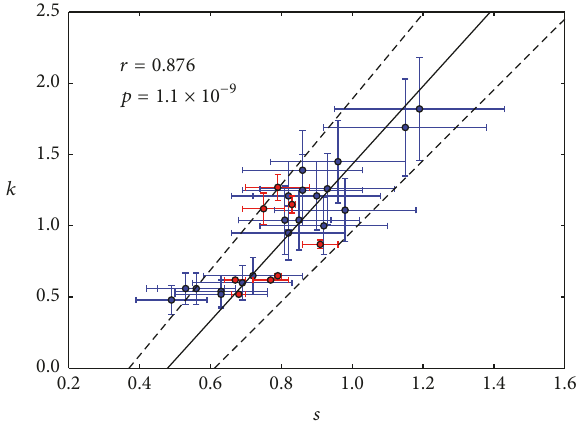
Figure 13: Luminosity ( 𝑘 )-stretch ( 𝑠 ) relation for relativistic type IcBL SNe [42]. For all filters from 𝑈𝐵𝑉𝑅𝐼 , and combinations thereof, GRB-SNe are shown in blue, and the two known relativistic type IcBL SNe (2009bb and 2012ap) are shown in red. A bootstrap analysis was performed to fit a straight line to the dataset to find the slope ( 𝑚 ) and 𝑦 -intercept ( 𝑏 ), which used Monte-Carlo sampling and 𝑁 = 10,000 simulations. The best-fitting values are 𝑚 = 2.72 ± 0.26 and 𝑏 = −1.29 ± 0.20 . The correlation coefficient is 𝑟 = 0.876 , and the two-point probability of a chance correlation is 𝑝 = 1.1 × 10 −9 . This shows that the 𝑘 - 𝑠 relationship is statistically significant at the 0.001 significance